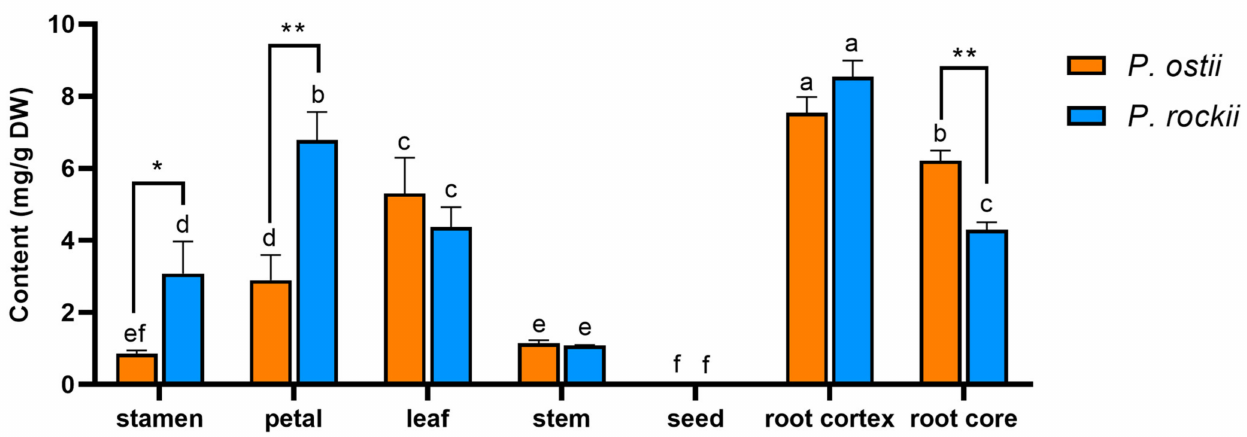
Figure 6. Content of representative gallotannin PGG in different tissues of P. rockii and P. ostii . * Significant difference at p < 0.05 level. ** Significant difference at p < 0.01 level. Different letters above the same color column indicate significant differences ( p <